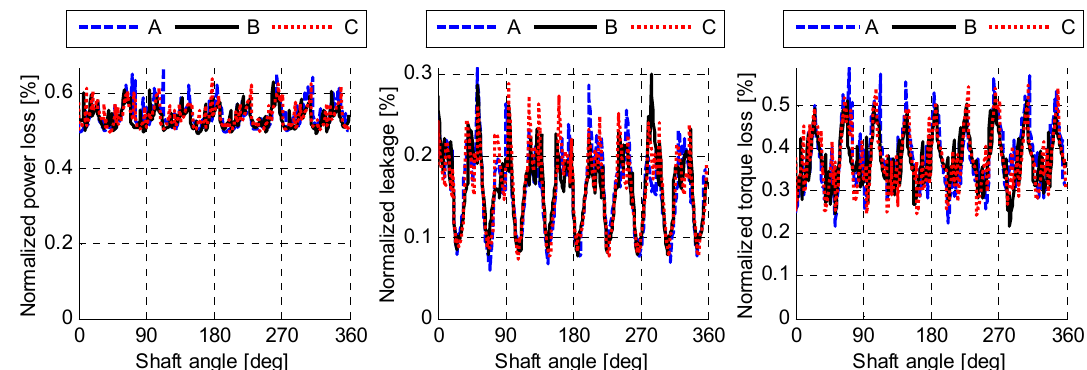
Energies 2018 , 11 , x FOR PEER REVIEW Figure 24. Normalized cylinder block/valve plate interface performance for different size units. Figure 24. Normalized cylinder block/valve plate interface performance for different size units. Figure 24. Normalized cylinder block/valve plate interface performance for different size units. Figure 24. Normalized cylinder block/valve plate interface performance for different size units.